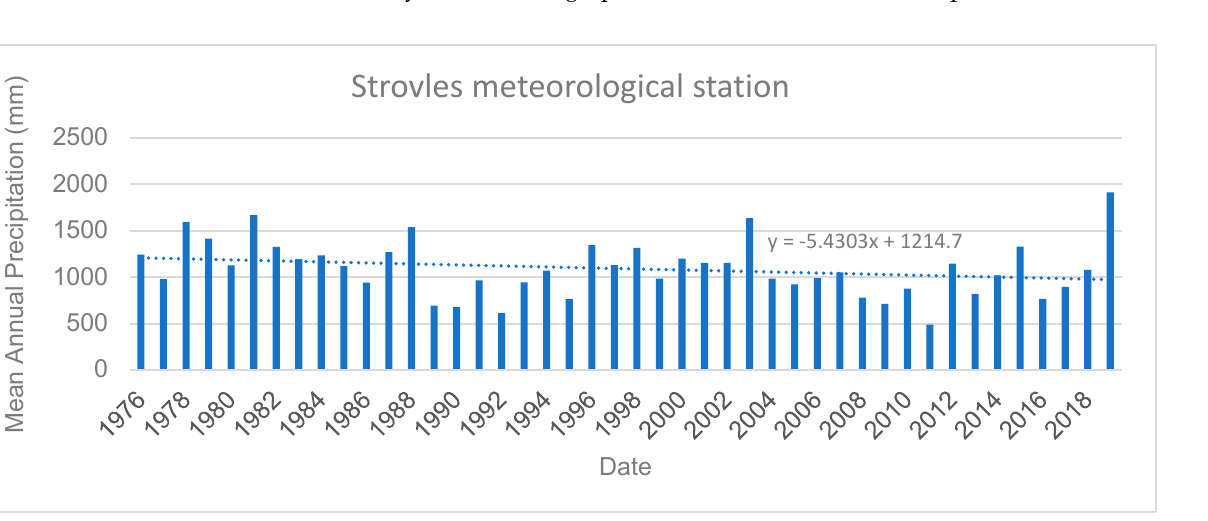
Figure 3. Total annual precipitation as per the Strovles meteorological station from 1976 to 2019.